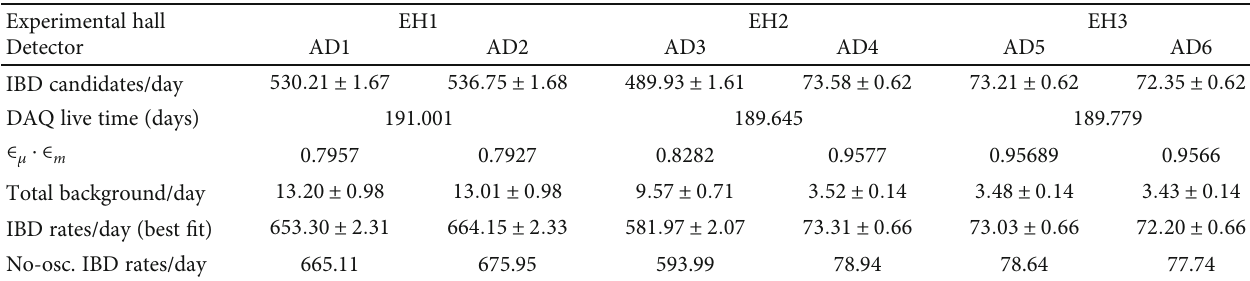
Table 1: Daya Bay IBD candidates and expected IBD rates and backgrounds per day in the 217-day sample used in this work. The DAQ live time and the muon veto and multiplicity-cut e ffi ciencies ( ∈ μ ⋅ ∈ m ) are also reported for each AD. The last line shows the expected IBD rate without oscillations. Adapted from [13].